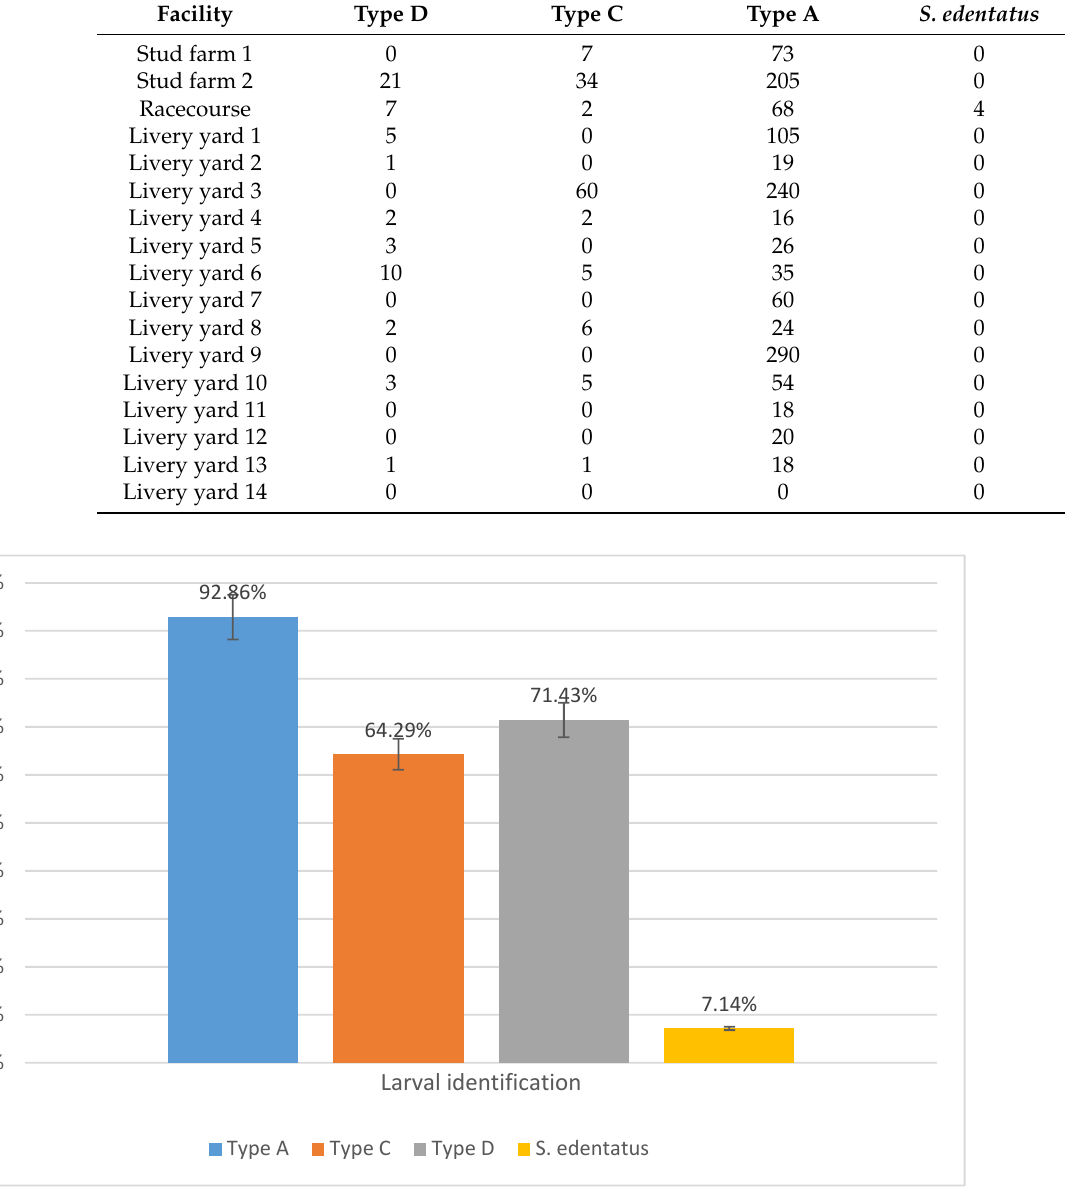
Table 3. Numbers of individuals within each larval type and strongyles in each of the enrolled facili- ties at T0. In each facility, for every positive horse, we morphologically identified 10 L3 specimens.